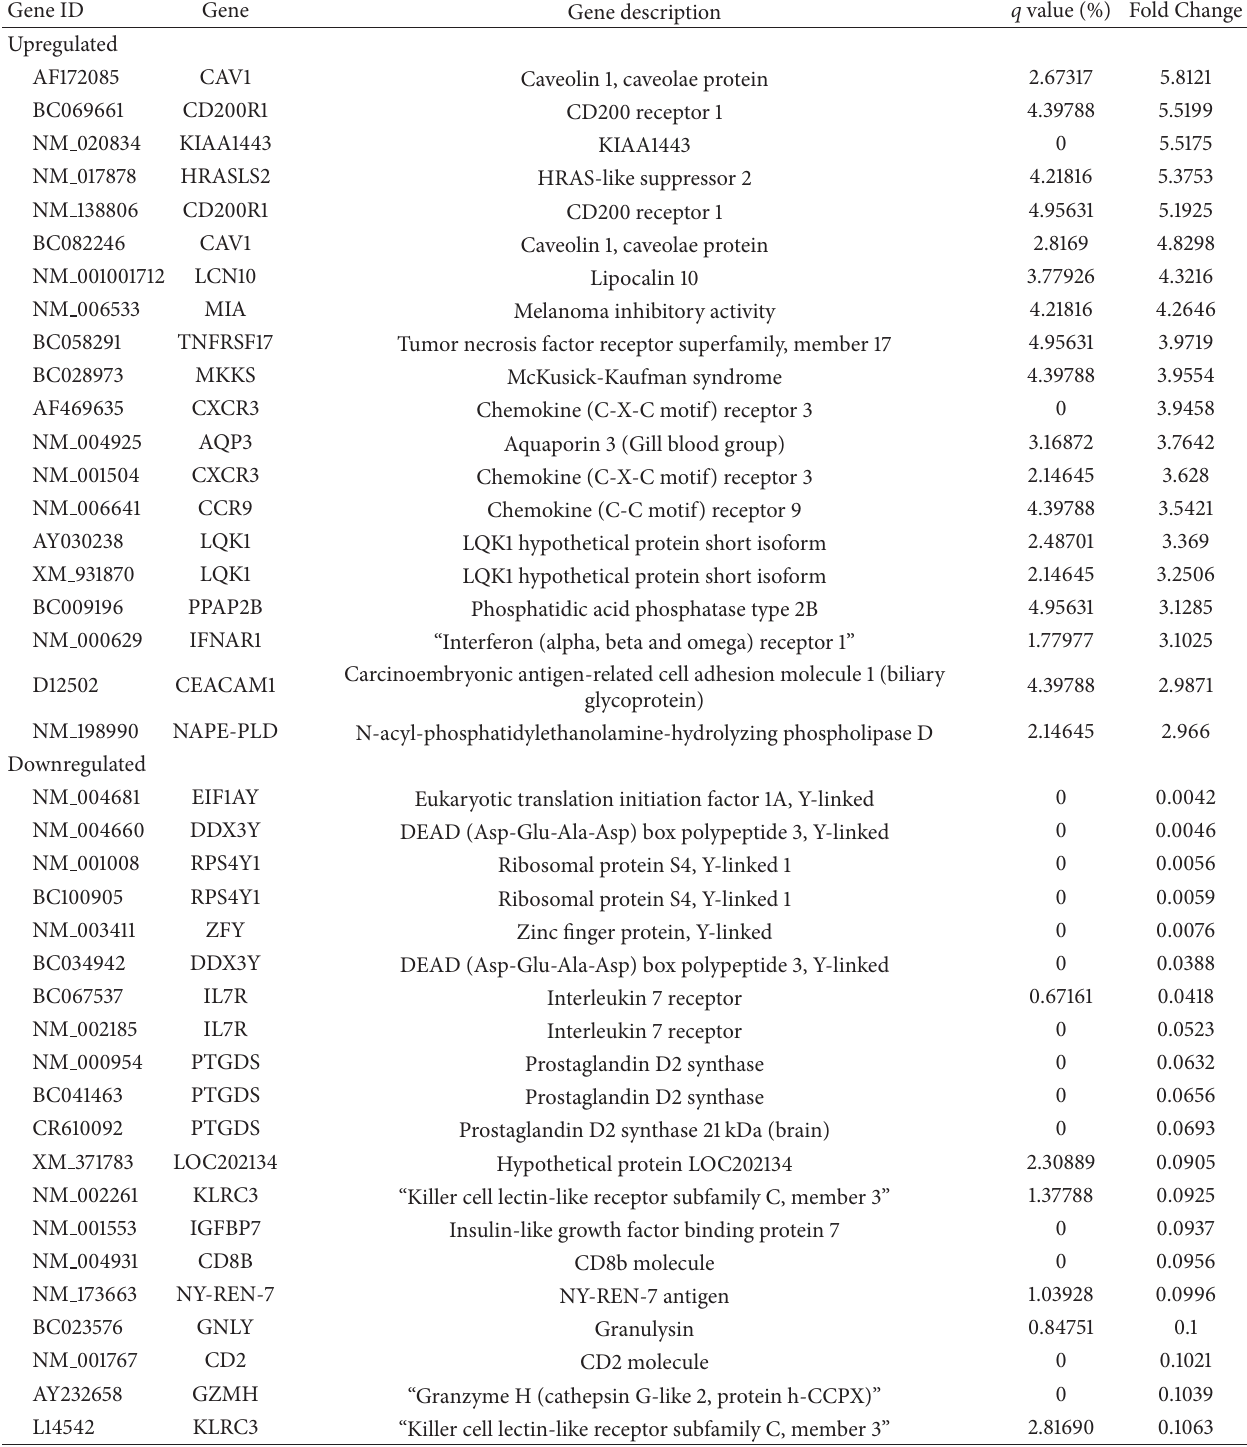
Table 3: The top 20 upregulated and downregulated estrogen-relevant DEGs between healthy females and males (fold change = ratio of healthy females/healthy